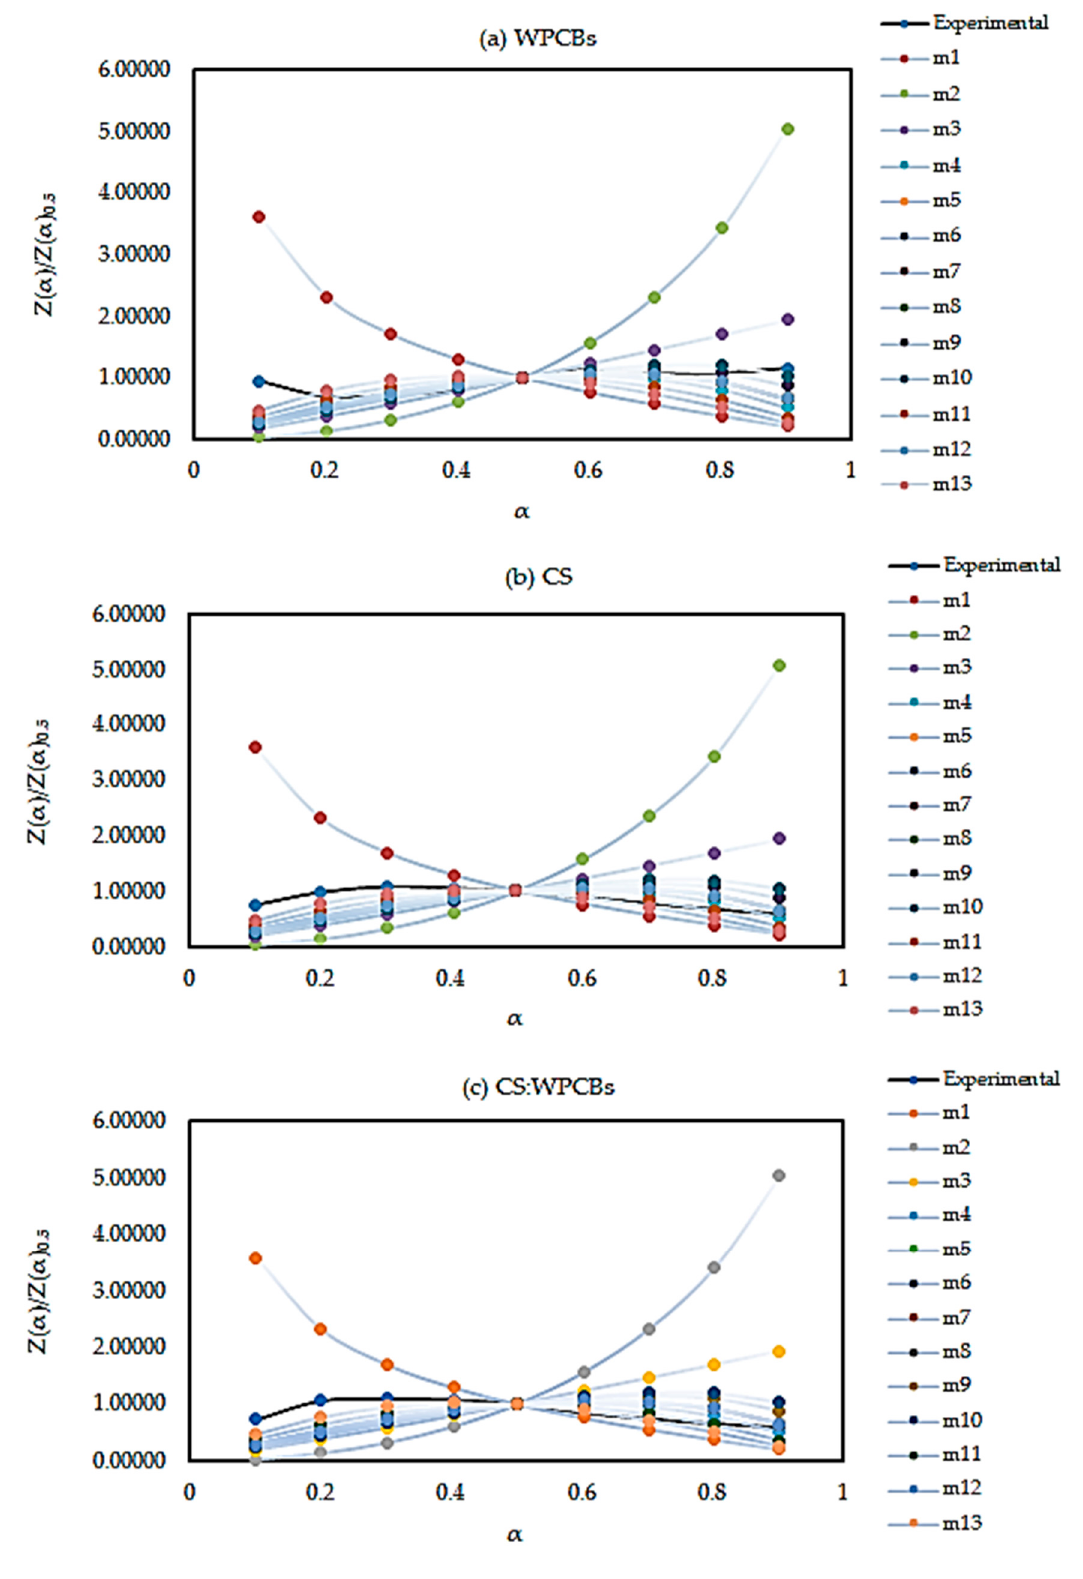
Figure 7. Experimental and Theoretical master plots for ( a ) WPCBs, ( b ) CS and ( c ) CS:WPCBs for second zone with heating rate 10 K/min .